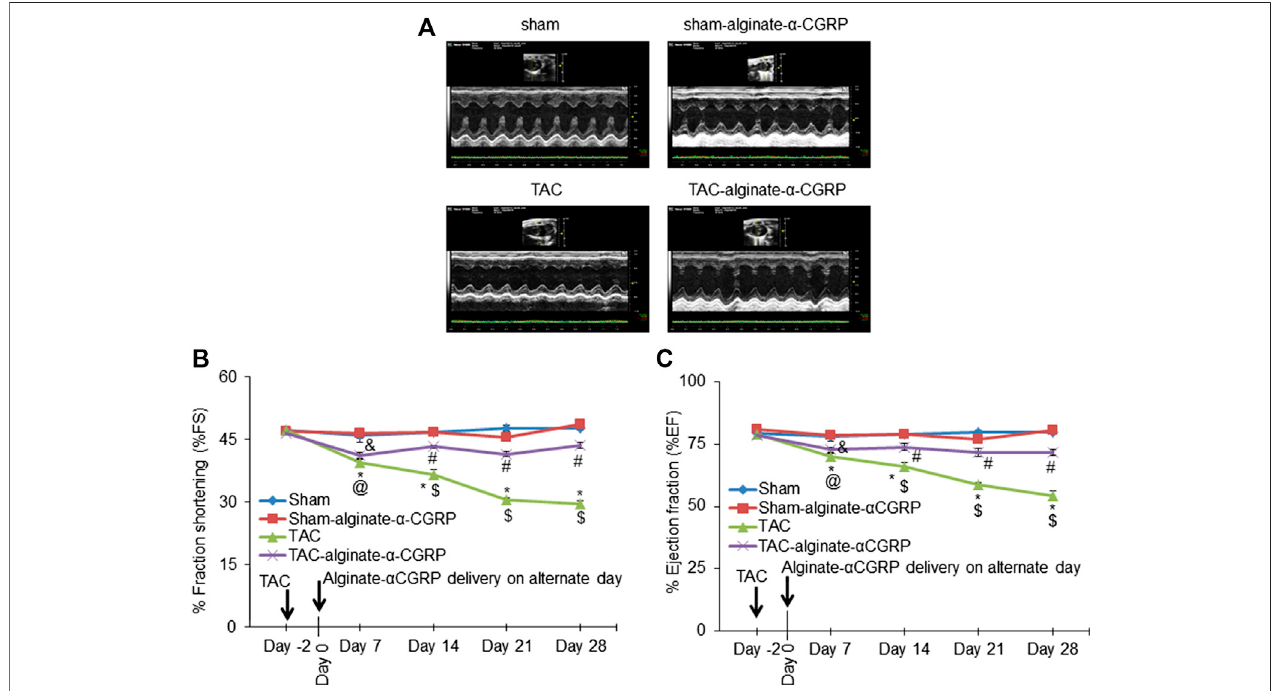
FIGURE 3 | Alginate- α -CGRP microcapsules delivery in two-day post-TAC mice improves cardiac functions. (A) Representative echocardiograms showing short axis B- and M-mode 2D echocardiography performed after 28 days of delivery of alginate- α -CGRP microcapsules in sham and TAC mice. Percentage fractional shortening (FS) and ejection fraction (EF) was calculated at various time points and plotted (B,C) . * p < 0.05, TAC vs sham at the same time point; # p < 0.05, TAC- alginate- α -CGRP vs sham at the same time point; $ p < 0.05, TAC vs TAC-alginate- α -CGRP at the same time point. @ p < 0.05, TAC day 7 vs TAC day-2; and & p < 0.05, TAC-alginate- α -CGRP on day 7 vs TAC-alginate- α -CGRP on